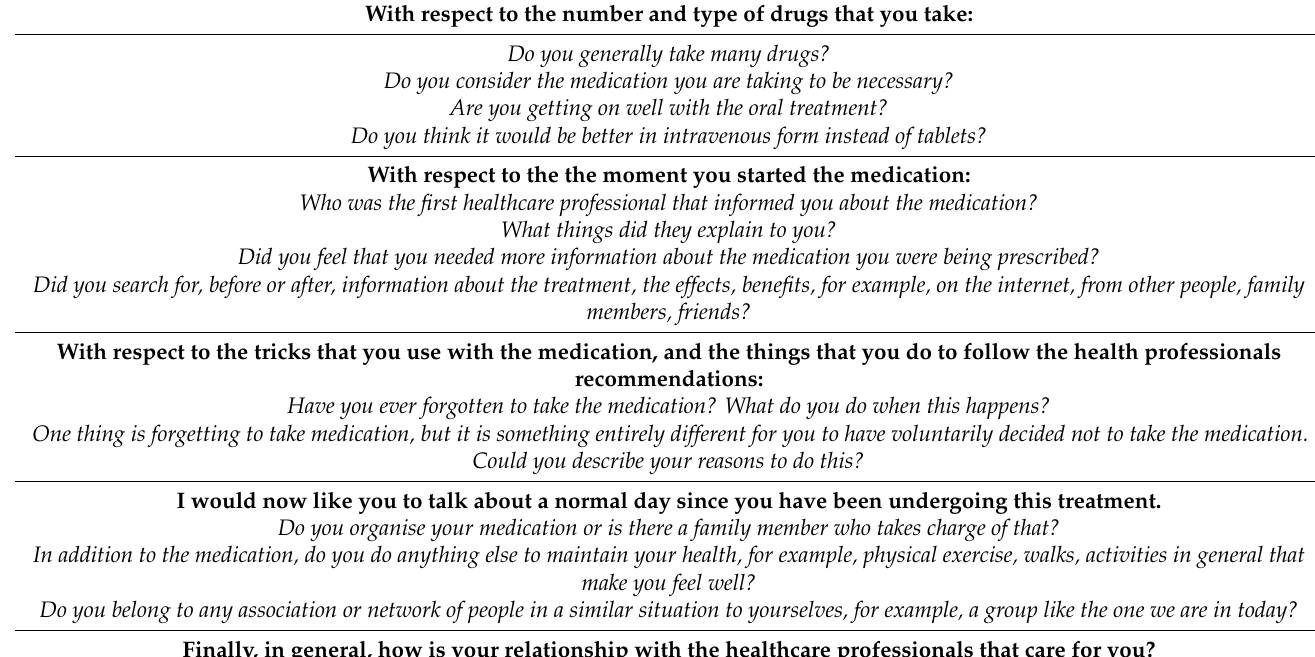
Table A1. Focus group questions: adherence to antineoplastic agents.